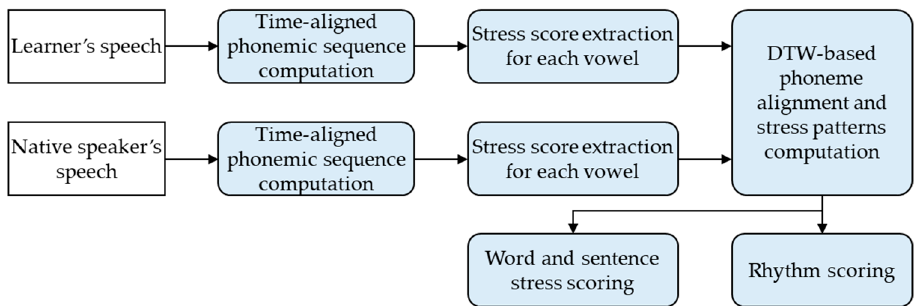
Figure 4. Block diagram of the proposed dynamic time-warping (DTW)-based stress and rhythm scoring method. scoring